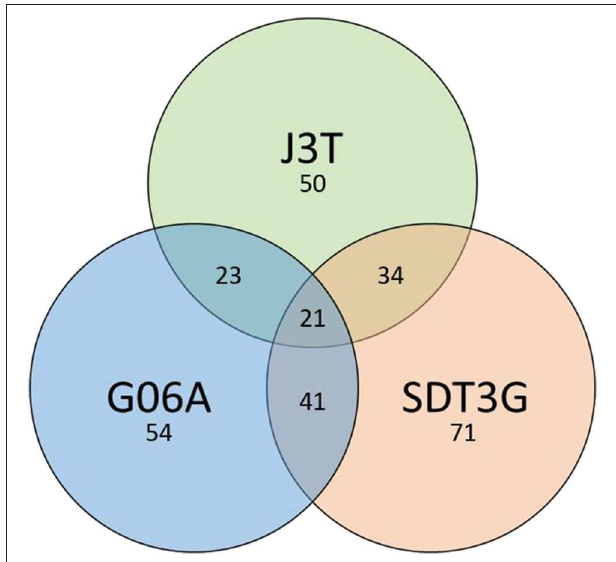
FIGURE 3 | Venn diagram of numbers of unique and overlapping differentially expressed miRNAs in hypoxia vs. normoxia for all cell lines.